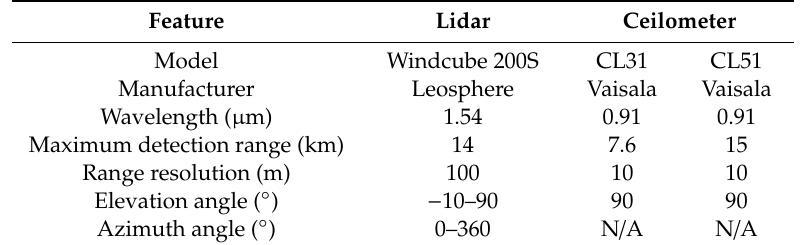
Table 2. The main specifications of the lidars and ceilometers operated in Iceland. Feature